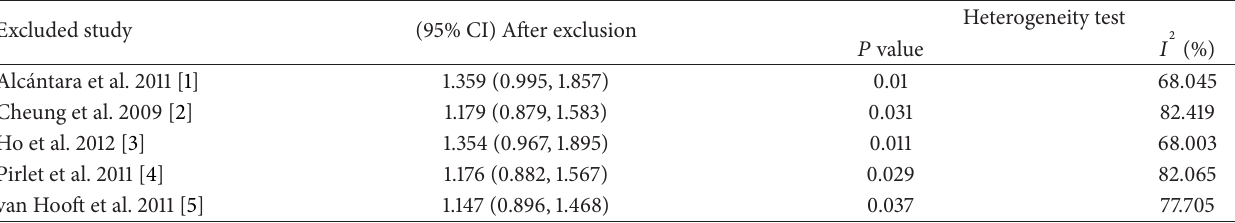
Table 4: Sensitivity test for meta-analysis of primary anastomotic rate of semielective surgery after SEMS installation versus emergency surgery.